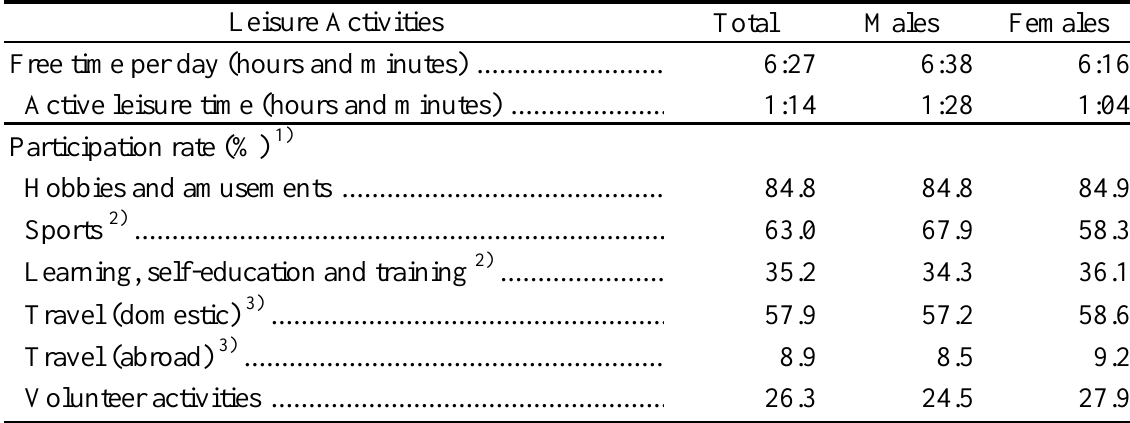
Table 16.4 Major Leisure Activities by Gender (10 years old and over)